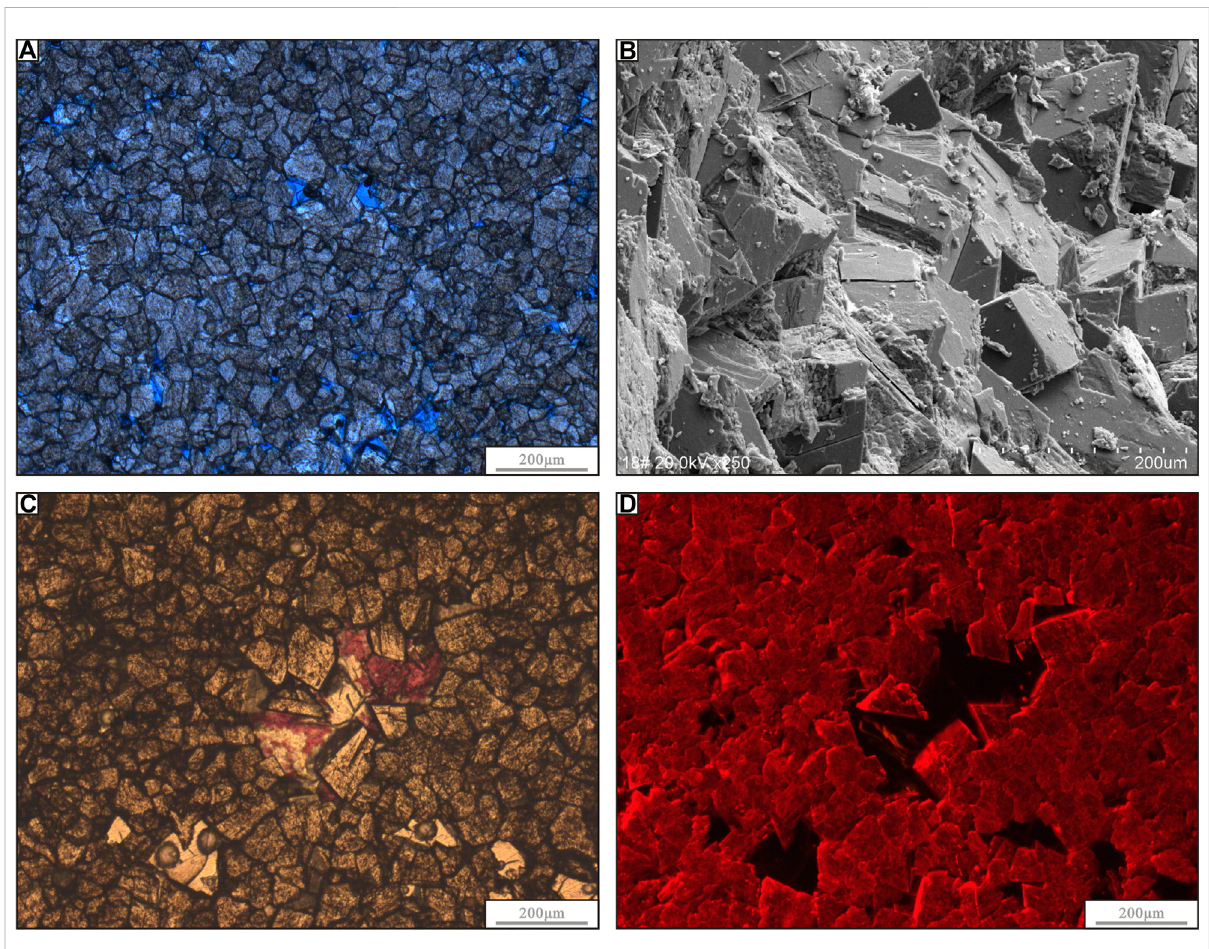
FIGURE 4 Petrological characteristics of Rd3. (A) . Plane-polarized-light image of an Rd3 sample with fi ne crystalline size showing planar subhedral textures, several dolomite areas with misty centers and clear rims, as well as un fi lled pores. The sample was obtained from well QK-1 in the Buqu Formation at a depth of 351.94 m. (B) . Scanning electron microscope image of an Rd3 sample showing planar subhedral textures due to dense dolomiteovergrowth.ThesamplewasobtainedfromwellQZ12intheBuquFormationatadepthof105.02 m. (C) .Plane-polarized-lightimage of an Rd3 sample with fi ne crystalline size showing planar subhedral textures, several areas of dolomite with misty centers and clear rims, and some calcite- fi lled pores. The sample was obtained from well QZ12 in the Buqu Formation at a depth of 54.86 m. (D) . Cathodoluminescence image of the Rd2 sample in (C) . These crystals show a very dull-dull orange, which is brighter in a few dolomite areas along the crystalline edge. The pores and calcite cement show no